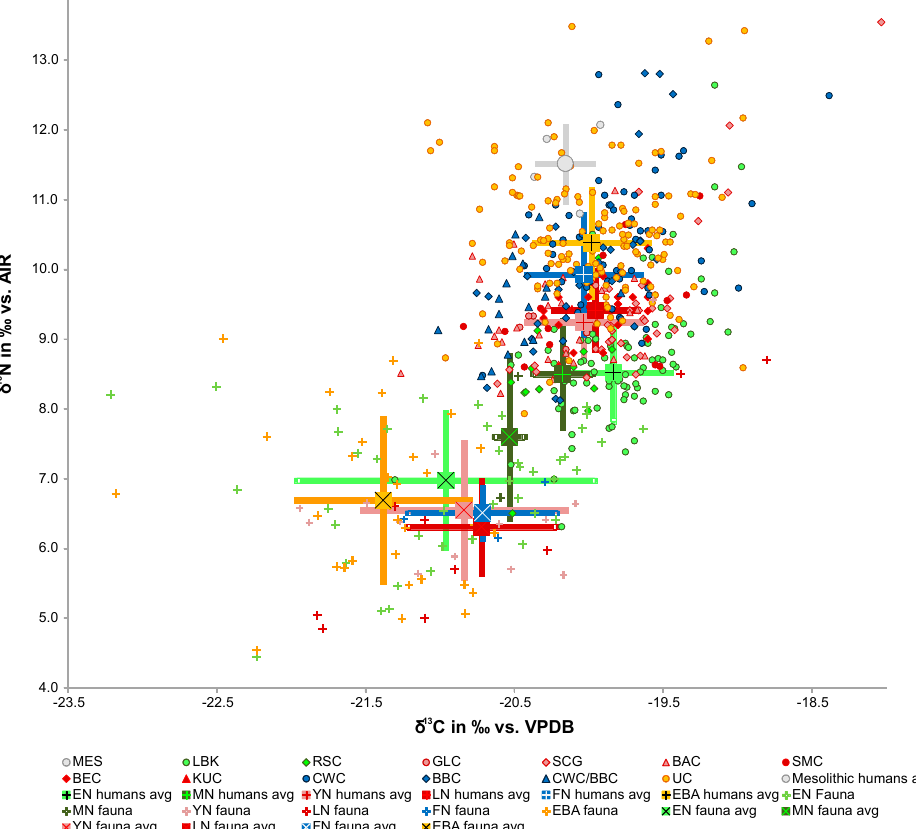
Figure 2. Stable isotope values of bone collagen samples from humans ( n = 482) and animals ( n = 109) from 26 Neolithic sites of different cultural groups in central Germany as well as one Mesolithic sample from Bottendorf, Thuringia (MES); Early Neolithic = light green, Middle Neolithic = dark green, Younger Neolithic = light red, Late Neolithic = dark red, Final Neolithic = blue, Early Bronze Age = orange. Each graph point represents one individual, either human or animal. The central finding is an increase in animal protein consumption (d15N) over time (mod. after Münster et al. [100]).